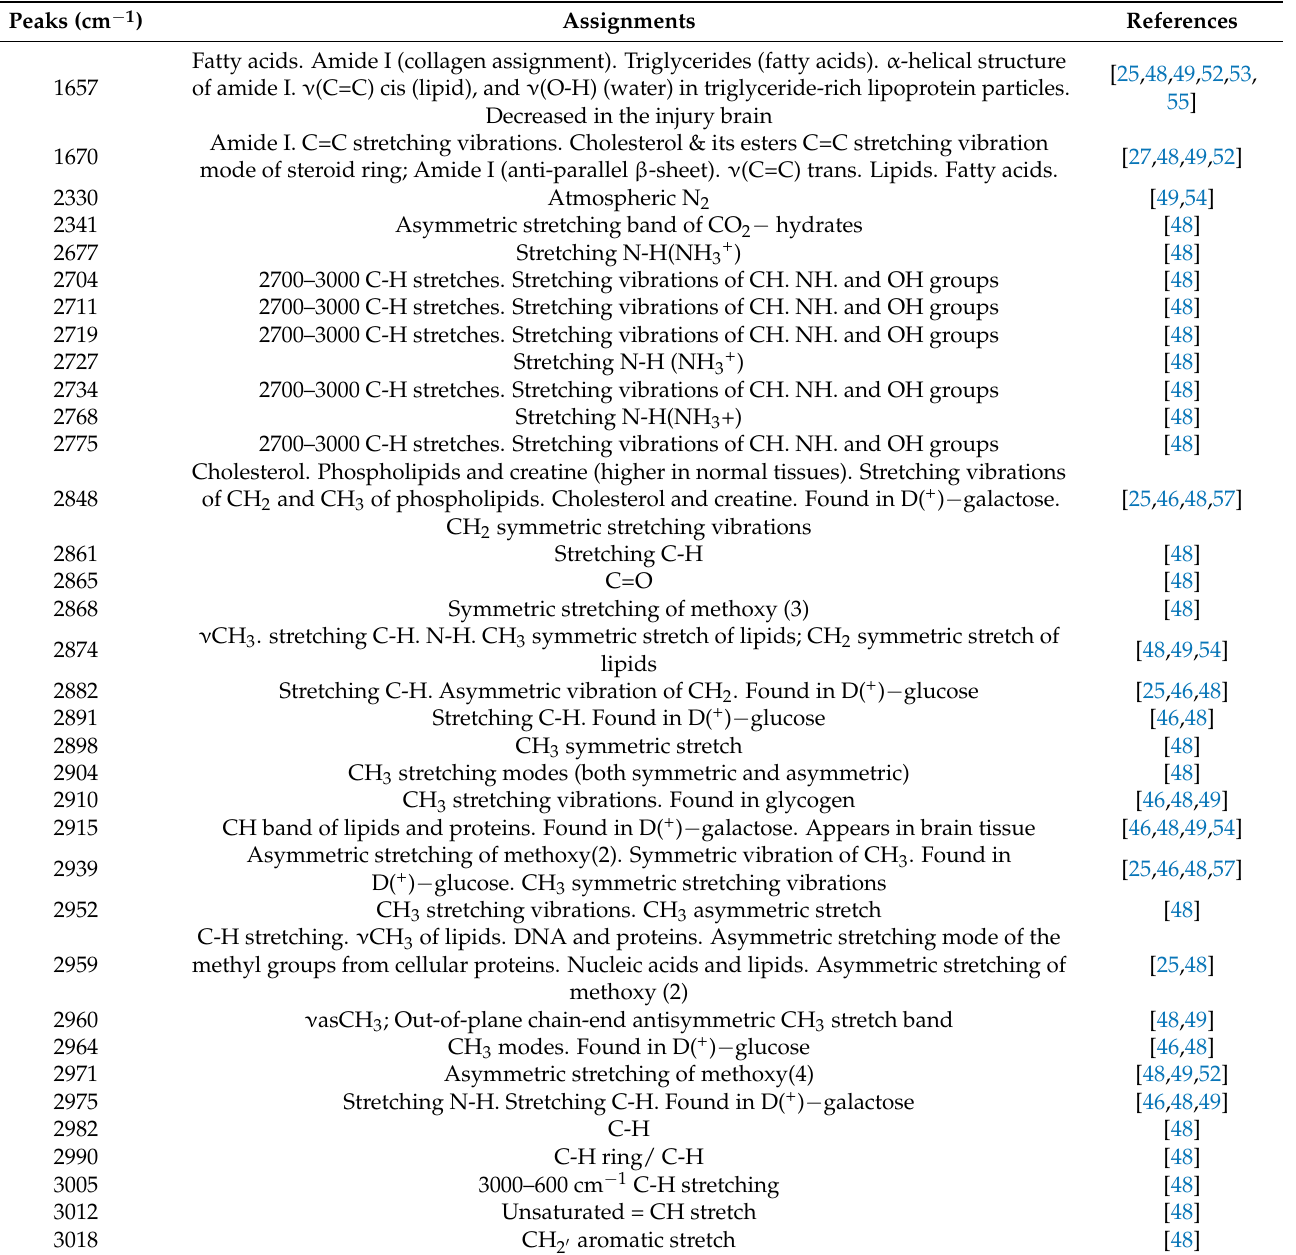
C-H stretching. ν CH 3 of lipids. DNA and proteins. Asymmetric stretching mode of the methyl groups from cellular proteins. Nucleic acids and lipids. Asymmetric stretching